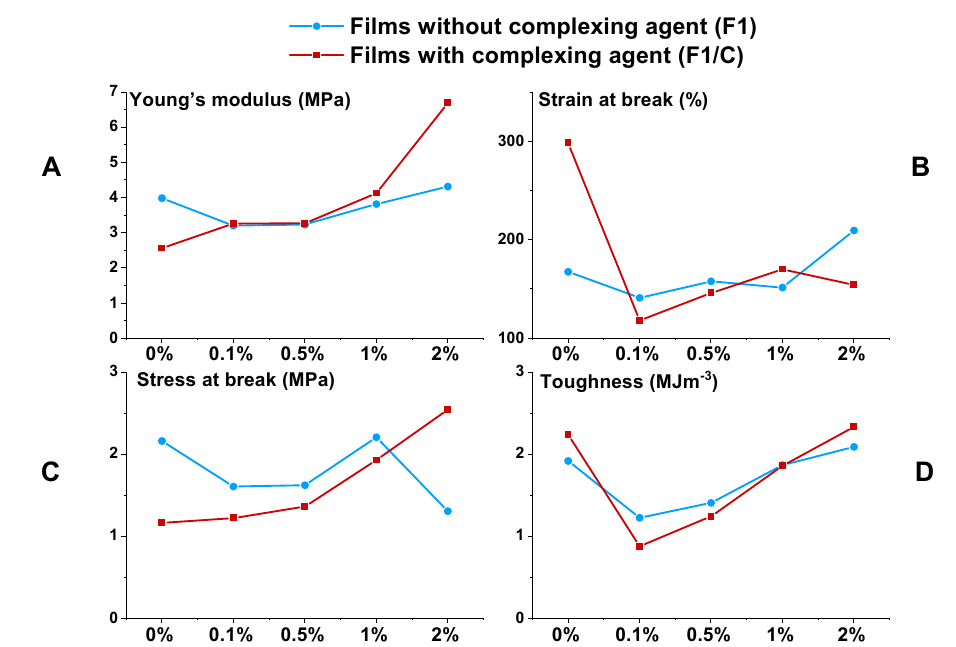
1 Calculated by integrating the stress–strain curve.